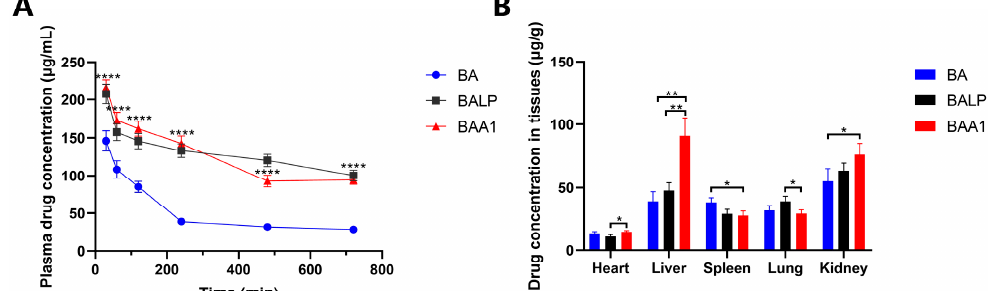
Figure 9. Pharmacokinetics and tissue distribution of BA, BALP, and BAA1 at the dose of 100 mg/kg. ( A ) The plasma BA concentration-time profiles in the mouse plasma were detected by HPLC. Data are presented as mean ± SD, n = 3; **** p < 0.0001. ( B ) Drug distribution in each tissue 2 h after administration, detected by HPLC. Data are presented as mean ± SD, n = 3; * p < 0.05, ** p < 0.01. Table 1. Main pharmacokinetic parameters of plasma in the normal mice. Parameters